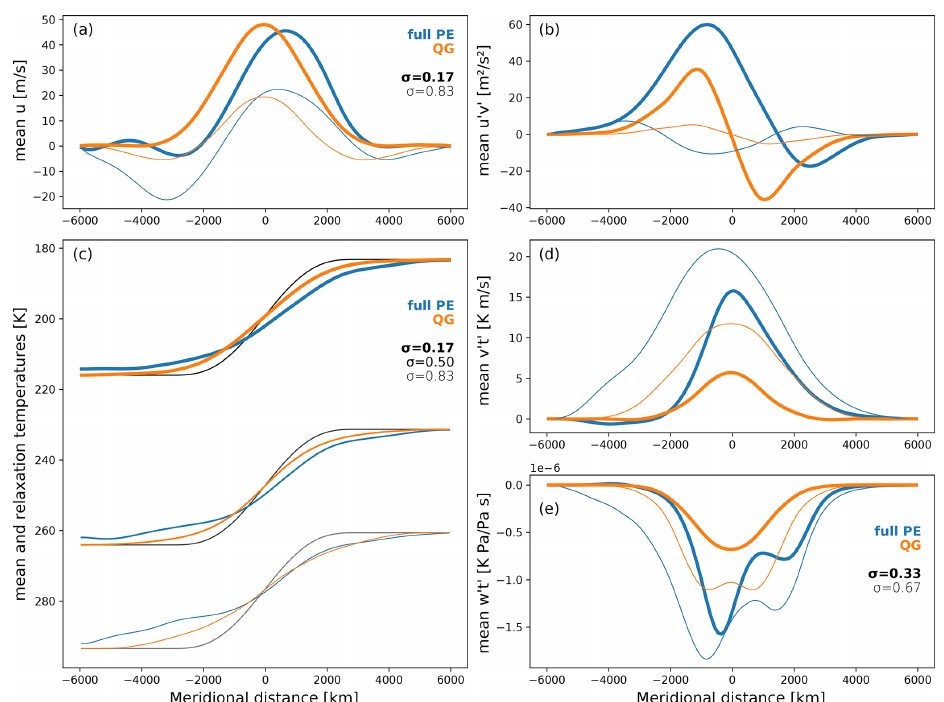
Figure 5. Statistical equilibrium state of the QG and full PE storm tracks, respectively. Line colour and weight are consistent throughout all the panels and identical for panels (a) , (b) , and (d) . Throughout this figure, blue lines represent full PE, and orange represent lines QG. Line weight indicates the vertical level, with the boldest lines representing the uppermost